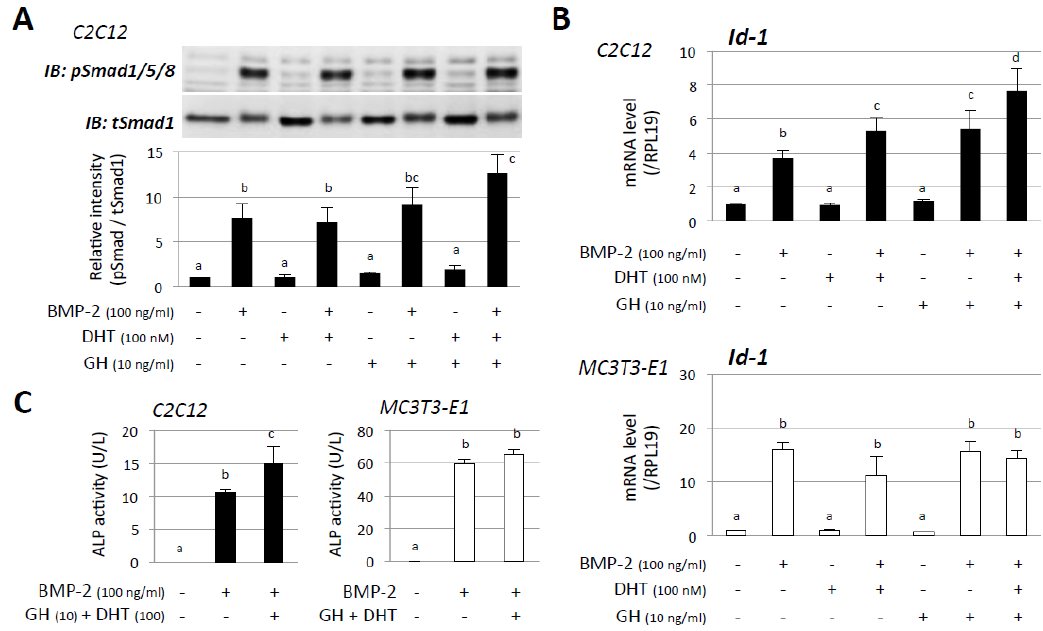
Figure 3. Effects of androgen and GH on BMP-receptor signal activation. ( A ) C2C12 cells (1 × 10 5 cells/well) were precultured in a serum-free condition in the absence or presence of DHT and GH for 48 h and were then stimulated with BMP-2. After 1-h culture with BMP-2 treatment, cells were lysed and subjected to SDS-PAGE/immunoblotting (IB) analysis using antibodies that can detect pSmad1/5/8 and tSmad1. The integrated signal density of each protein band was digitally analyzed, and the ratios of signal intensities of pSmad/tSmad1 were calculated; ( B ) C2C12 and MC3T3-E1 cells (2 × 10 5 cells/well) were treated with the indicated concentrations of DHT, GH, and BMP-2 in a serum-free medium. After 48-h culture, total cellular RNA was extracted and mRNA levels of Id-1 were examined by real-time RT-PCR. The expression levels of the target gene were standardized by RPL19 mRNA levels in each sample; ( C ) C2C12 and MC3T3-E1 cells (1 × 10 5 cells/well) were treated with the indicated concentrations of BMP-2, DHT, and GH in a serum-free medium for 72 h, and then ALP activity in the cell lysates was determined. Results in all panels are shown as means ± SEM of data from at least three separate experiments, each performed with triplicate samples. The results were analyzed by ANOVA. For each result within a panel, the values with different superscript letters are significantly different at p <